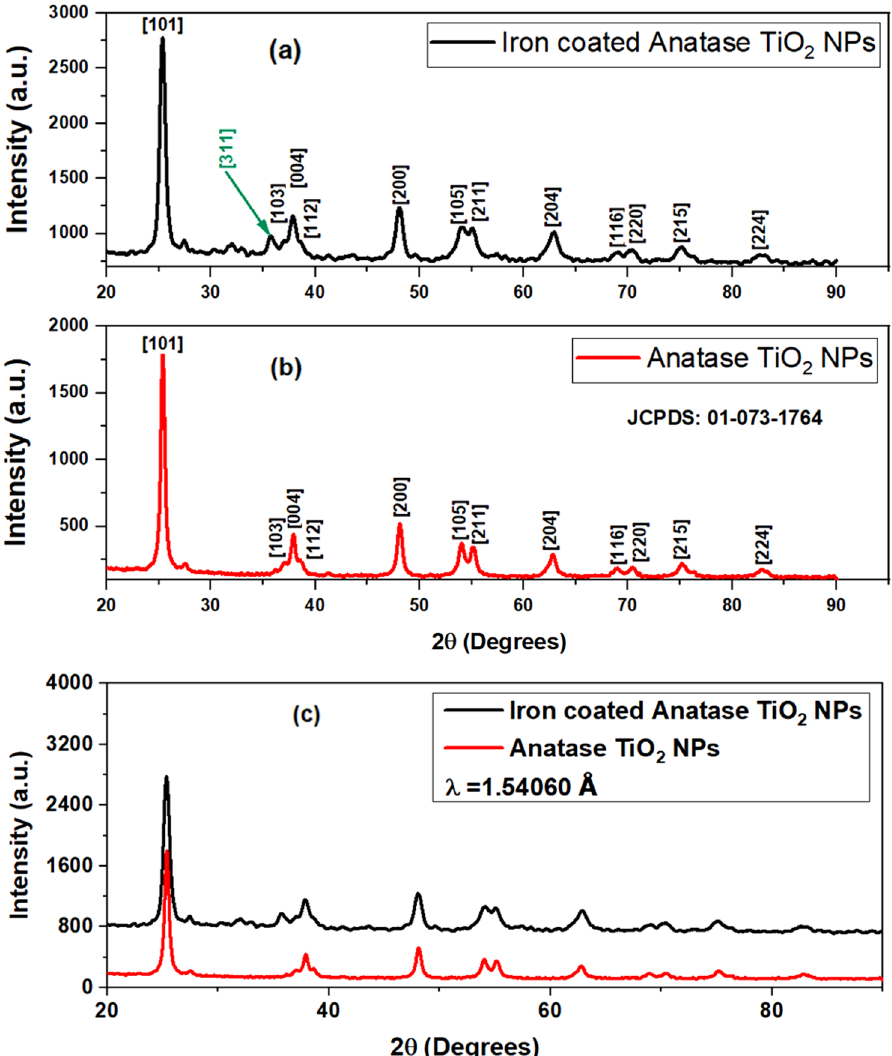
Figure 2. XRD pattern of ( a ) Fe@TiO 2 NPs, ( b ) TiO 2 NPs and ( c ) superimposed XRD plots obtained in ( a ) and ( b